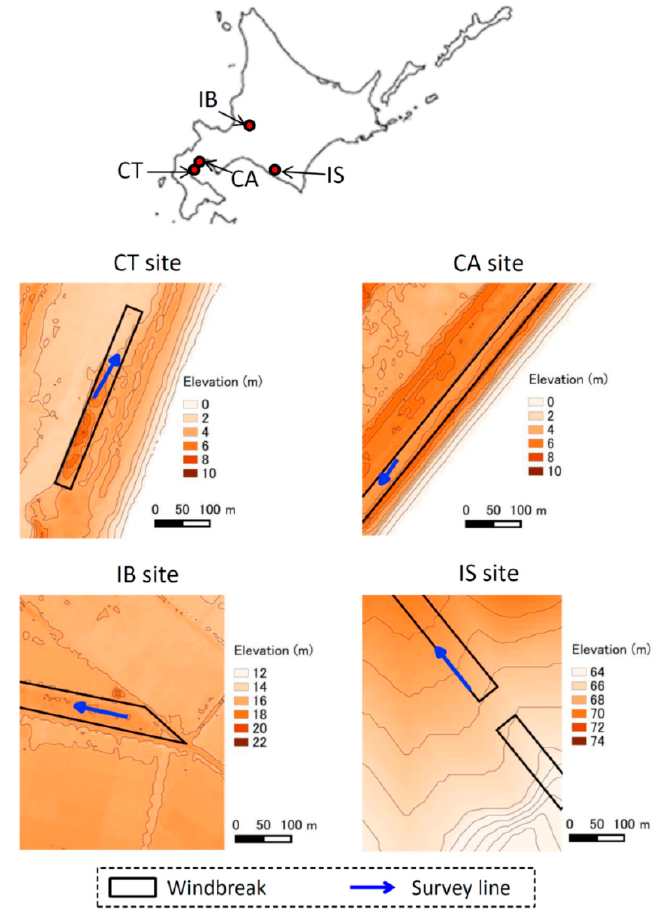
Figure 1. Locations and topography of study sites. Interval of contours is 1 m. Topographic data are based on 5-m (CT, CA, and IB sites) or 10-m (IS site) digital elevation models of the Geospatial Information Authority of